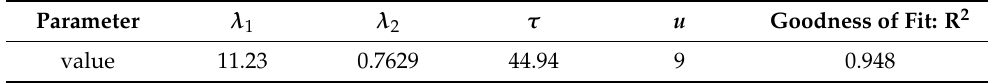
Table 2. Fitted results of GelMA microfiber with different concentrations. Table 1. Fitted result by SLS